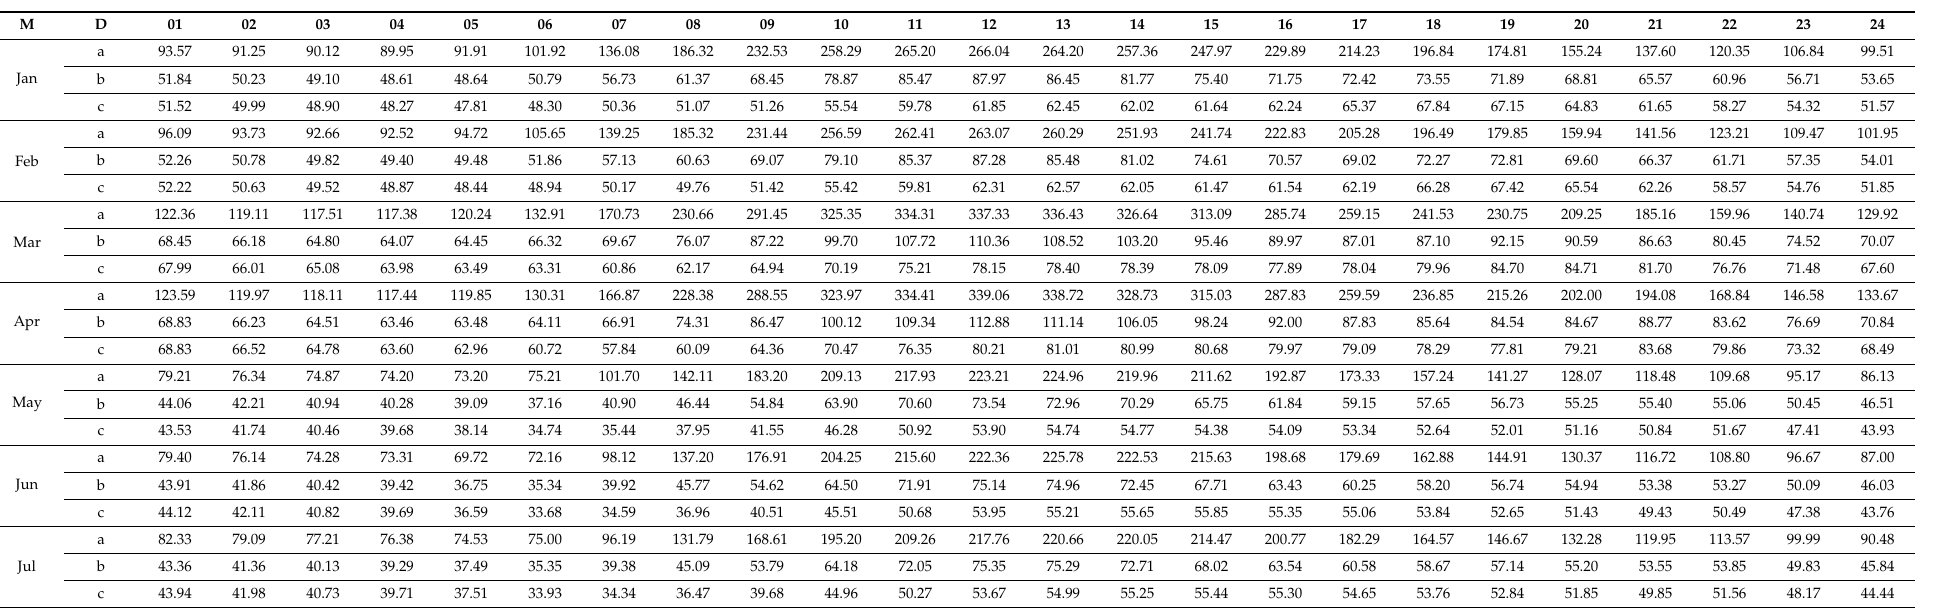
Table A3. Assumed profile in one-year period with 1-hour resolution, as representative of a B23 consumer: M—month; D—day type; a—working day; b—Saturday; c—Sunday or